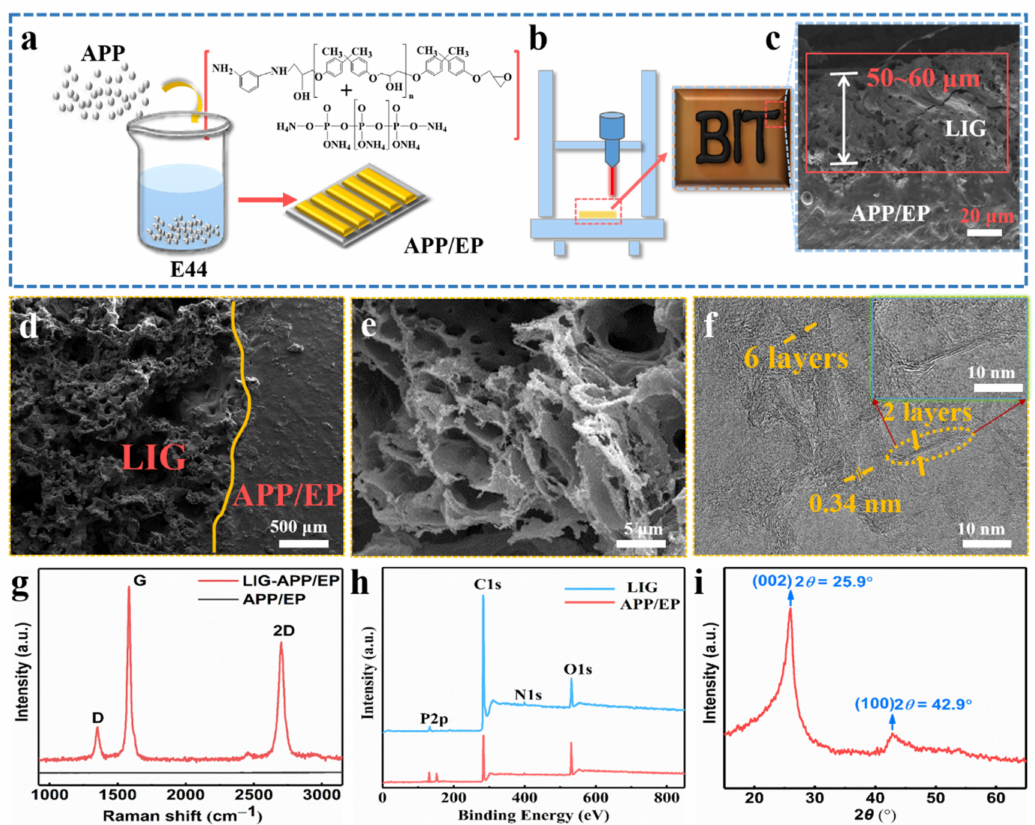
Figure 1. Fabrication of the specimens and the characterization of the laser-induced graphene (LIG). ( a ) Processing route of the ammonium polyphosphate and epoxy (APP/EP) composites. ( b ) Processing route for fabricating an LIG layer on the APP/EP surface. The inset shows a photograph of the LIG patterned into “BIT” on the APP/EP. ( c ) Scanning electron microscopy (SEM) image of the cross-section of the LIG sample. ( d ) Enlarged SEM cross-section image of the LIG area. The smooth region was the APP/EP substrate. The porous region on the left was the LIG layer. ( e ) High-resolution SEM image of the LIG formed on the APP/EP. ( f ) High-resolution transmission electron microscopy (HRTEM) image of the LIG. The yellow arrows mark the few layers of graphene. The average lattice spacing was 0.34 nm. ( g ) Representative Raman spectrum of the LIG layer and the APP/EP composite, where the illustration is a magnified view of a location marked in yellow in ( f ). ( h ) Representative X-ray photoelectron spectroscopy (XPS) spectrum of the LIG layer and the APP/EP composite. ( i ) X-ray diffraction (XRD) spectrum of the LIG scraped from the APP/EP. The (002) planes of the graphitic materials corresponded to the 0.34 nm distance marked in the HRTEM